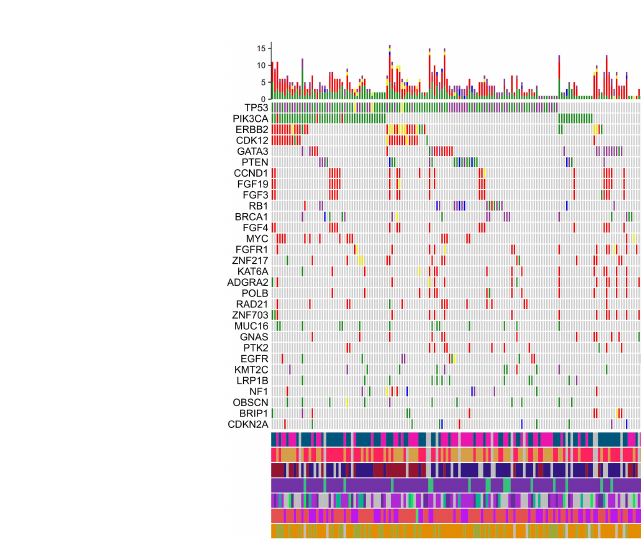
FIGURE 1 | Mutational landscape of breast cancer. Five types of mutations are indicated with different colors in the heatmap plot. The top bar plot summarizes the mutation type proportion in each patient. The below color bar indicates the clinical characteristics of each patient. The heatmap shows the mutations at each gene in each